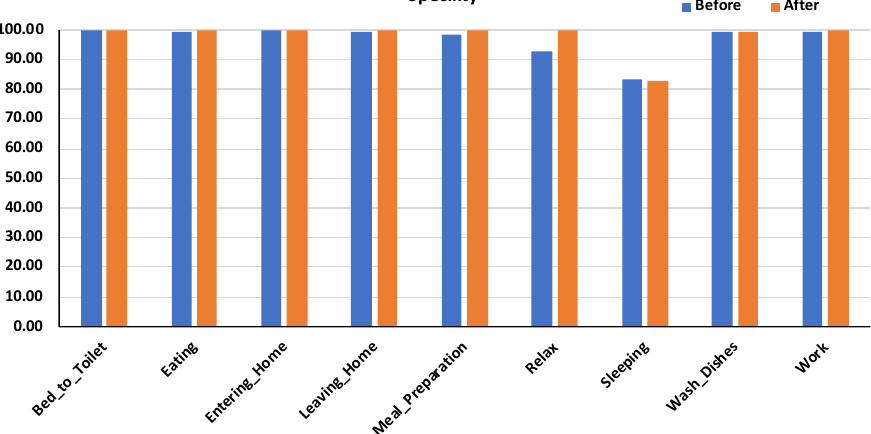
Figure 13. Comparison of specificity values of paradigm #3 before and after applying semantic